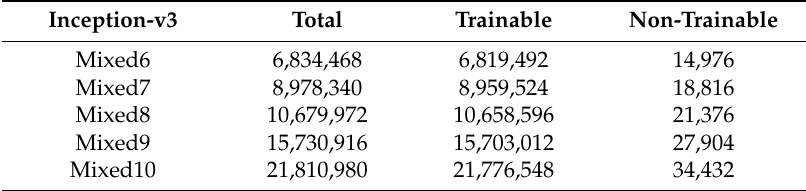
Table 1. The number of parameters in Inception-v3